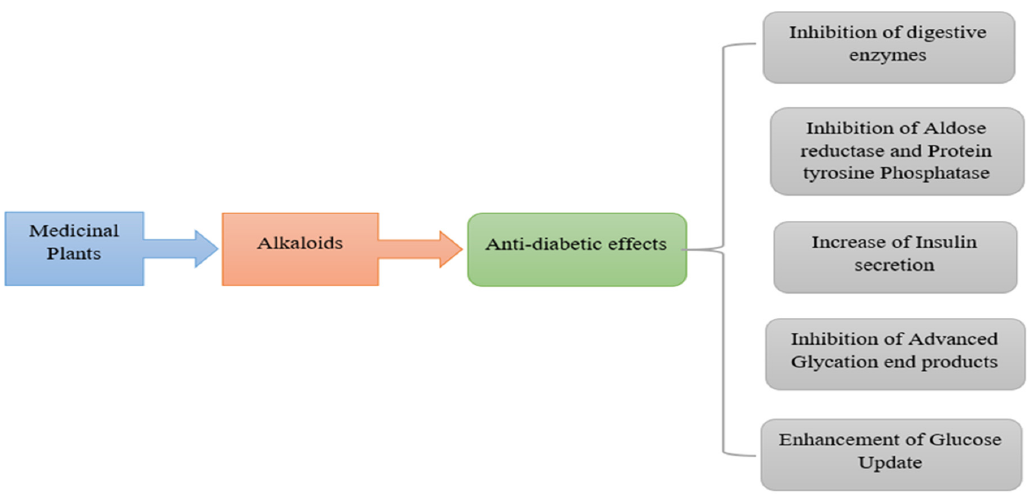
Figure 1. Mechanism involved in the antidiabetic activity of alkaloidal phytoconstituents . Different kinds of anti ‐ hyperglycemic medications have been introduced during the